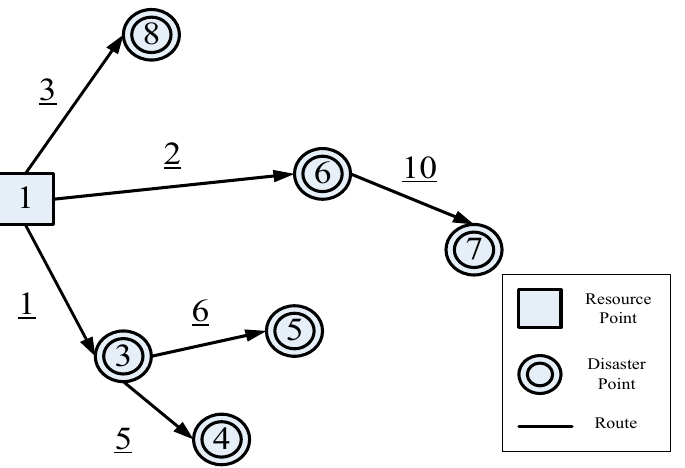
Figure 5. Diagram of emergency repair process at the initial stage of the disaster (Case 2).